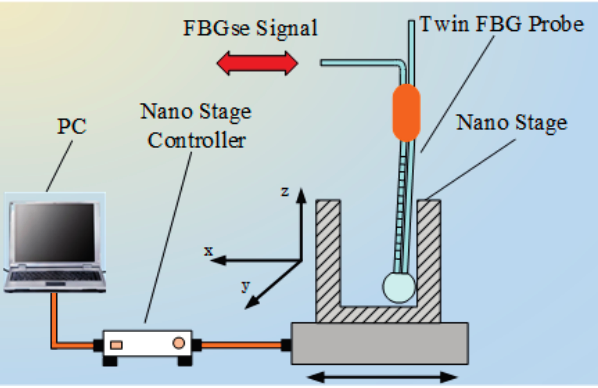
reflection spectrum power of the seFBG and reFBG to the reflection spectrum power of the seFBG on a large scale, while Figure 12b shows the available measurement scale.